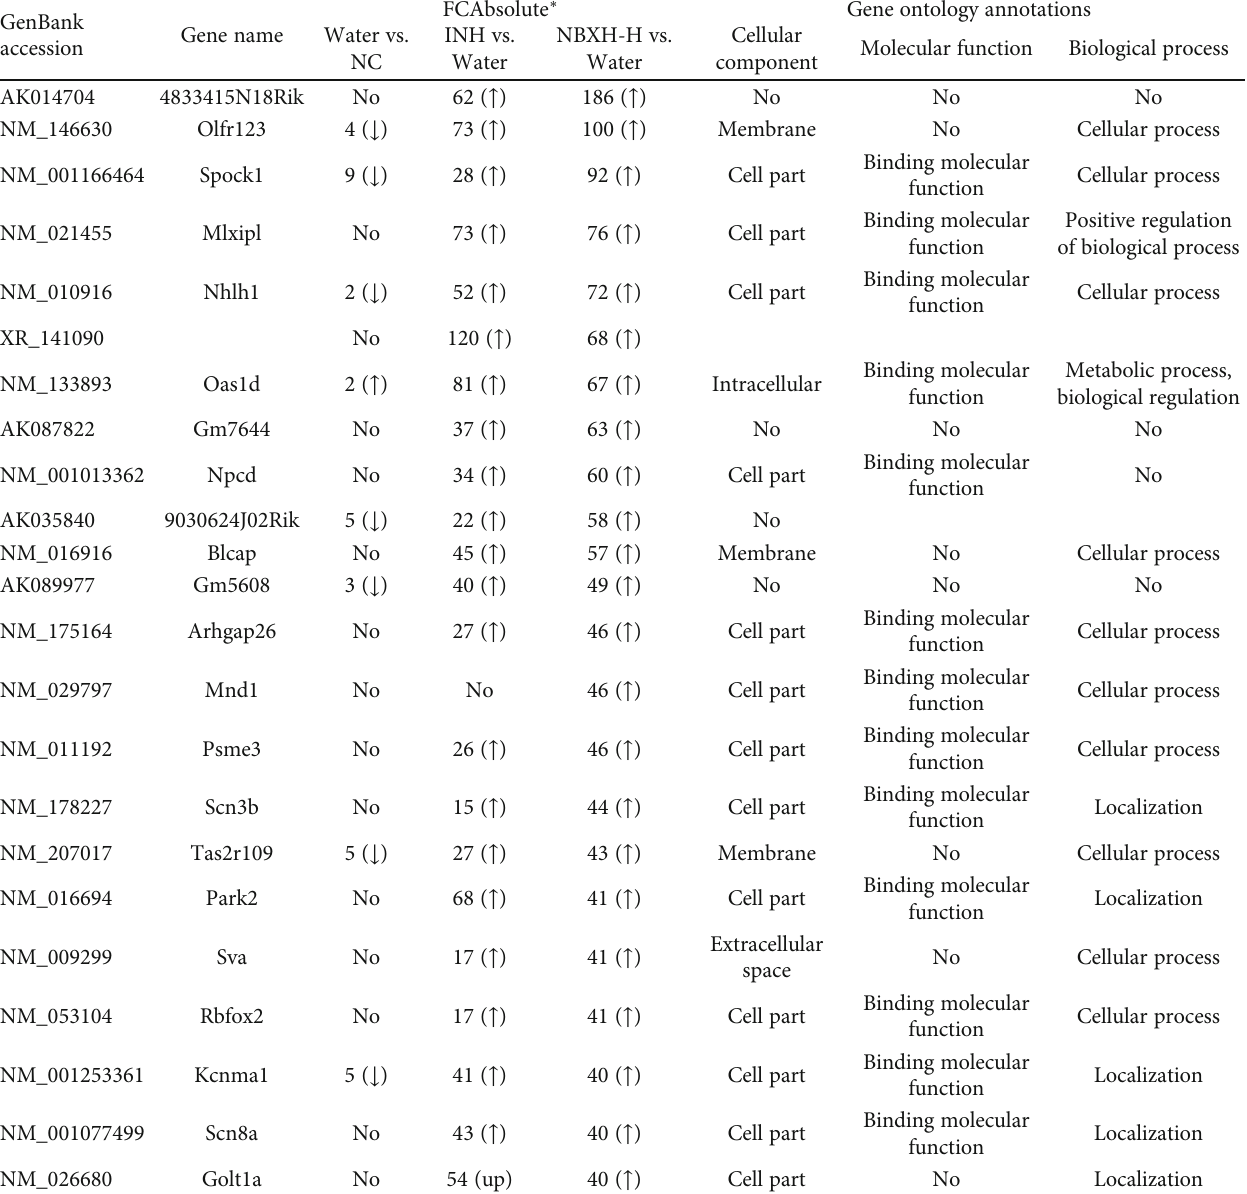
Table 3: The signi fi cant upregulated genes after NBXH-H